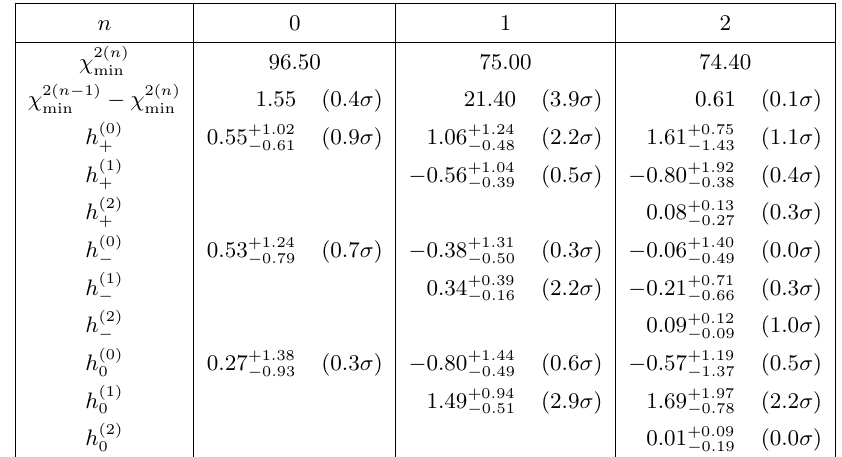
Table 6 . Fit to exclusive b ! se + e (cid:0) and b ! s(cid:22) + (cid:22) (cid:0) observables with C (cid:22); NP same approach as in ref. [12]. All coe(cid:14)cients are given in units of 10 (cid:0) 4 . Di(cid:11)erent orders n of the polynomial parametrisation of the long-distance charm-loop contribution for B ! V ‘ + ‘ (cid:0) are considered. If this contribution is set to zero, the (cid:12)t yields (cid:31) 2